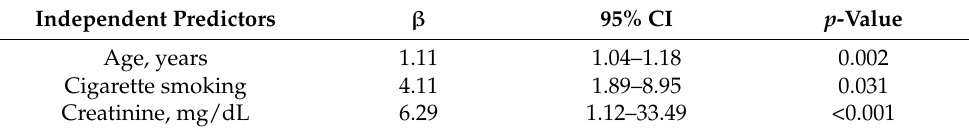
Table 4. Parameters dysregulated in active smokers in multivariate logistic regression Table 3. Predictors of peripheral artery disease in multivariate logistic regression analysis.